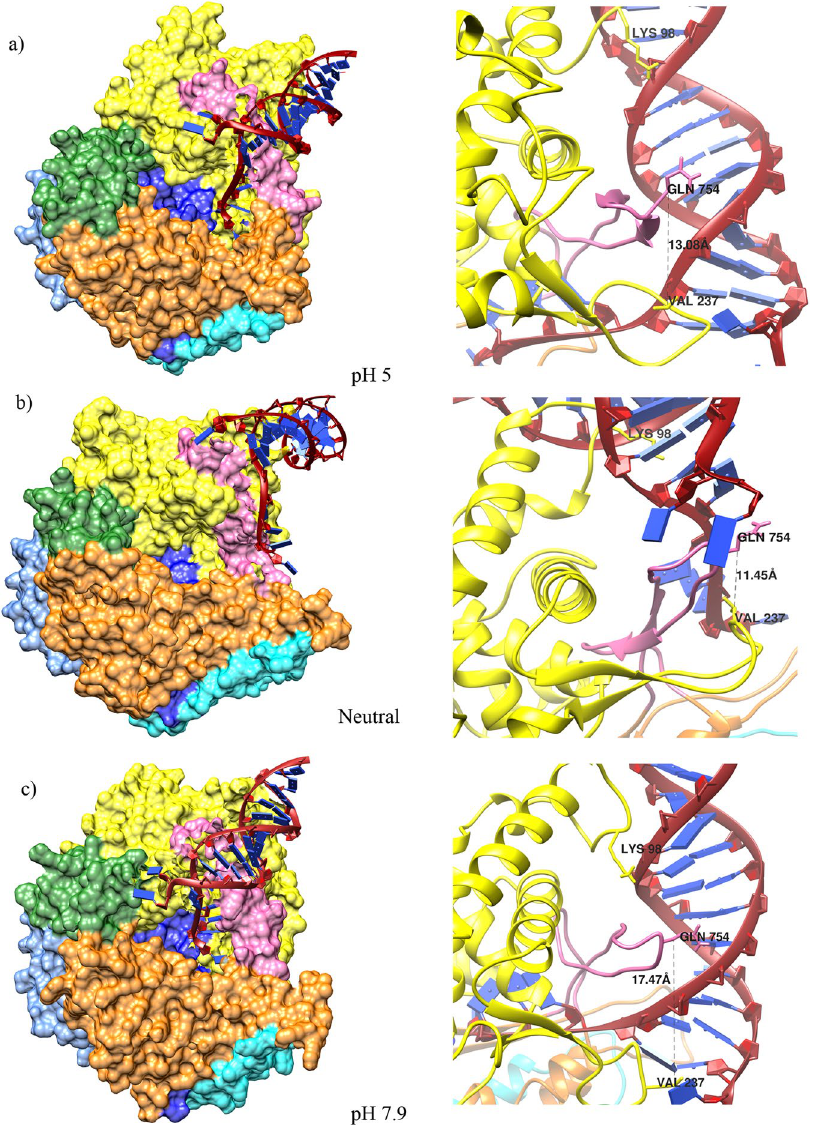
Figure 6. The docked complexes of T7 promoter DNA and T7RNAP at different pH strengths ( a ) pH 5, ( b ) Neutral and ( c ) pH 7.9. The color representation for T7RNAP was kept same as in Fig. 1. The right panel shows a close up view of the interacting loops in each